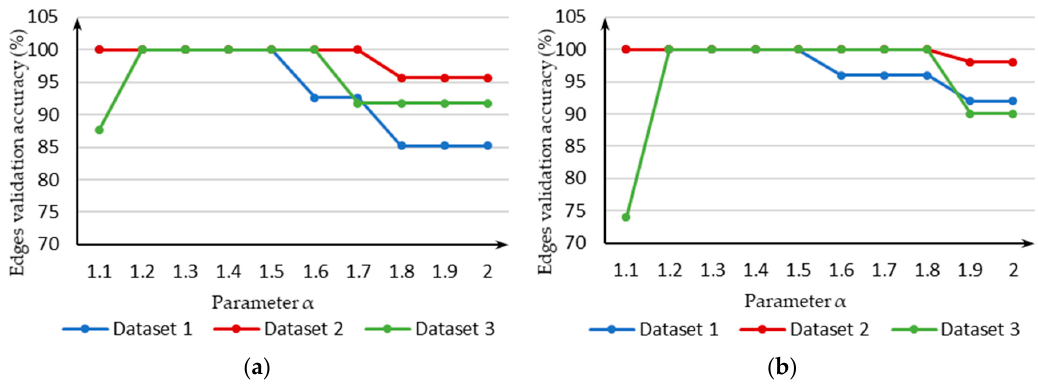
Figure 18. The edge validation results with different values of parameter α . ( a ) the results of datasets with the Cartographer algorithm; ( b ) the results of datasets with the LOAM algorithm.